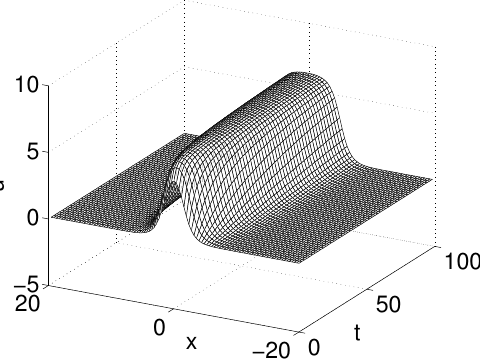
Figure 1. The numerical solutions from t = 0 to t = 100 with τ = 0.02 and h = 0.4.